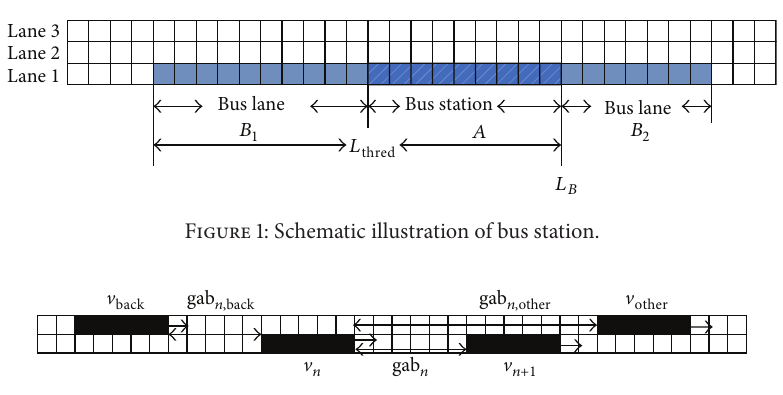
Figure 2: Schematic illustration of lane changing